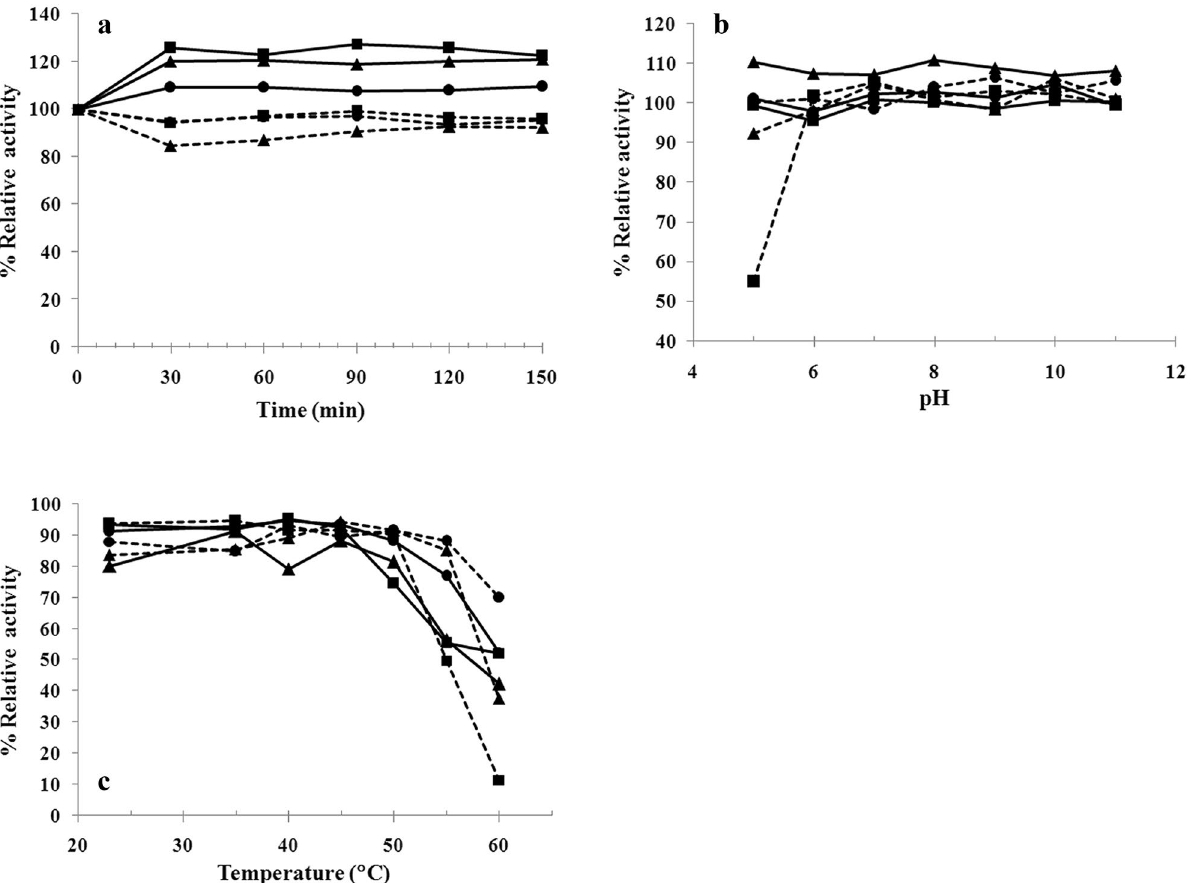
Figure 4. Effects of incubation time ( a ), pH ( b ) and temperature ( c ) on amylase and alkaline proteases activities (- ■ -, Puntius gonionotus ; - -, Puntioplites proctozysron ; - ▲ -, Oreochromis niloticus . Dashed lines represent the relative activity of amylase, whereas solid lines represent the relative activity of alkaline ●